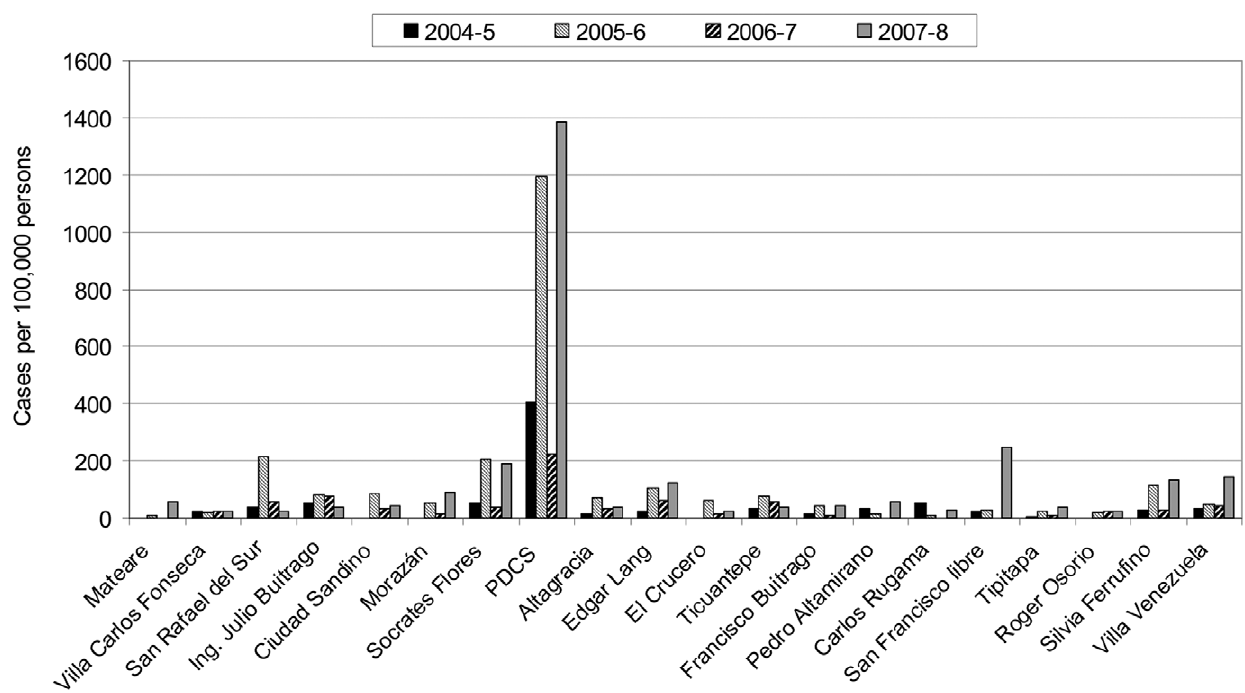
Figure 1. Reported laboratory-confirmed dengue cases among children in Managua health centers and in the PDCS, 2004–8. Laboratory-confirmed dengue cases among 1–14 year-old children in 2004–5 and 2–14 year-old children in 2005–8 reported in Managua health centers by the NES and in 2–12 year-old children meeting the WHO case definition in the PDCS 2004–8.